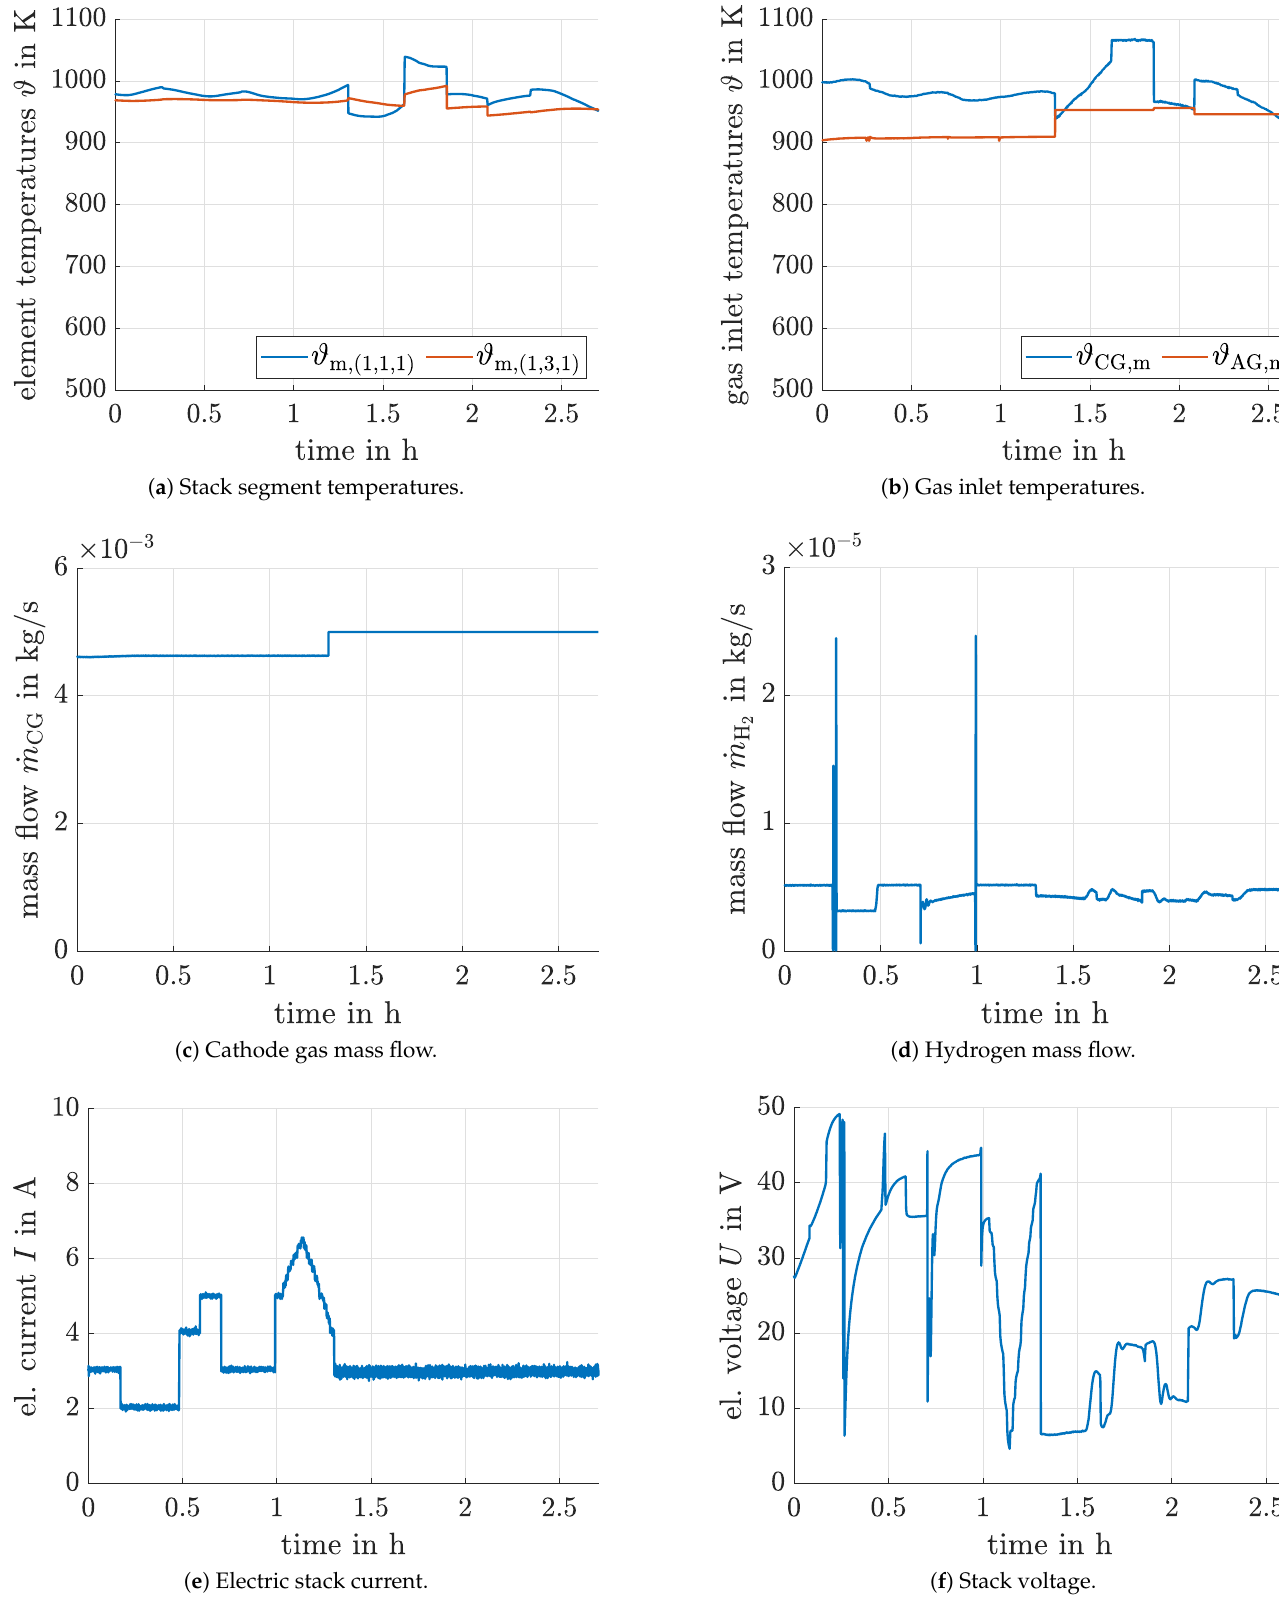
Figure 4. System inputs for the neural network model identification (experimental